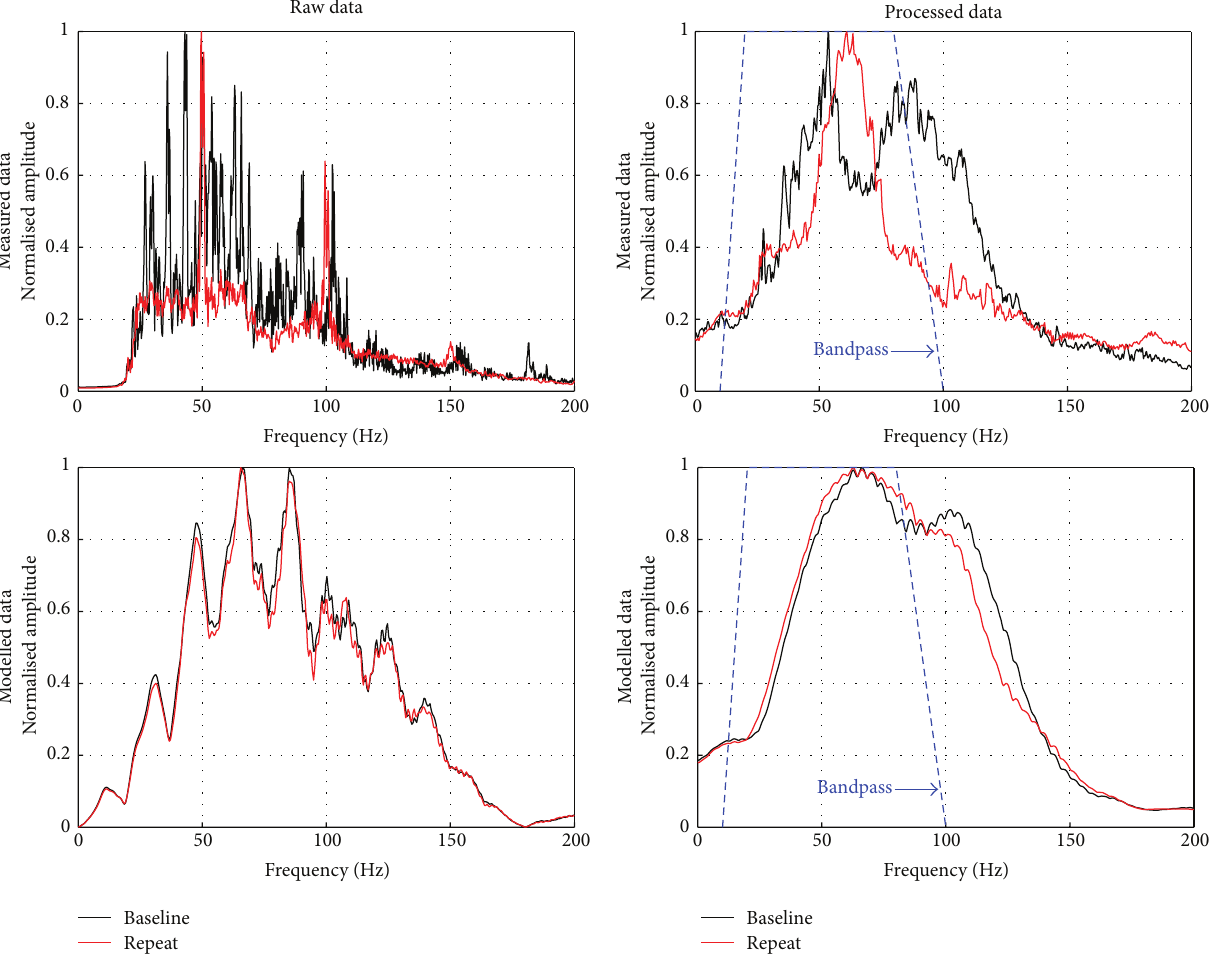
Figure 5: Normalised amplitude spectra of the zero-offset VSP baseline for measured and modelled data (top and bottom row). Baseline and repeat measurements are plotted as black and red lines. In the left and right columns, spectra of raw data and processed data are shown. The blue line indicates the corner frequencies of a bandpass filter (10–20–80–100 Hz) which is applied during the processing.